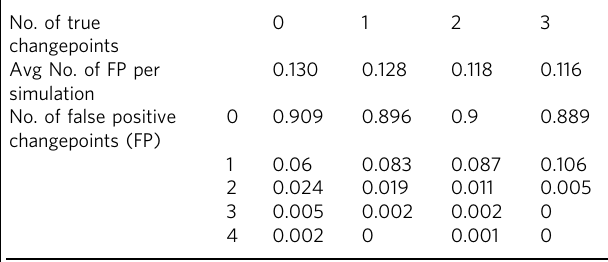
Table 2 False positives rates in non-parametric